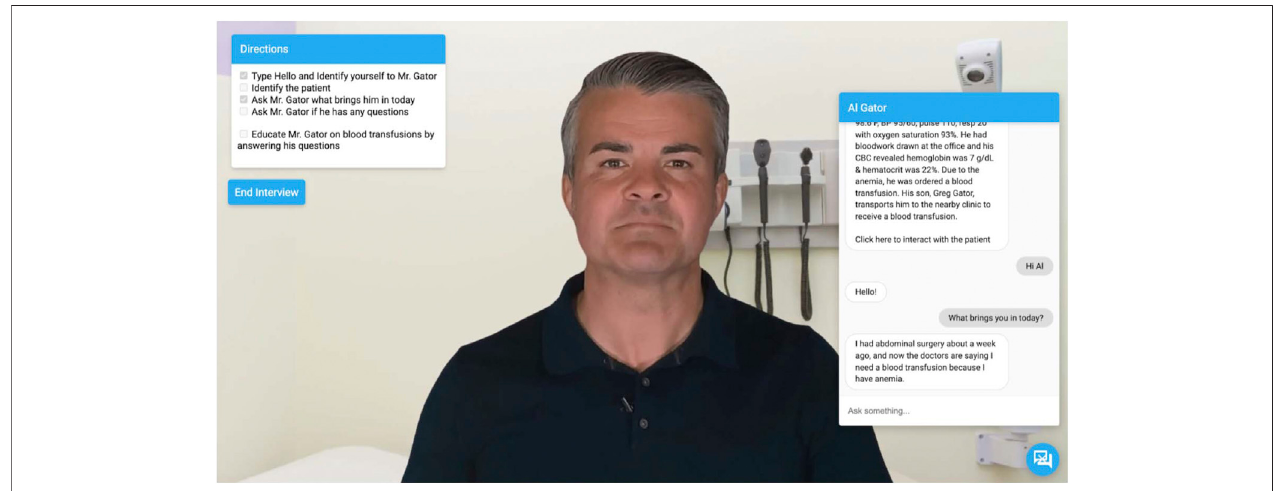
FIGURE 1 | The interface used to interact with the virtual humans. The interface contains 1) the virtual human, 2) the directions window, 3) the Google DialogFlow Messenger integration that enables conversation with the virtual human, and 4) the button used to end the interaction.